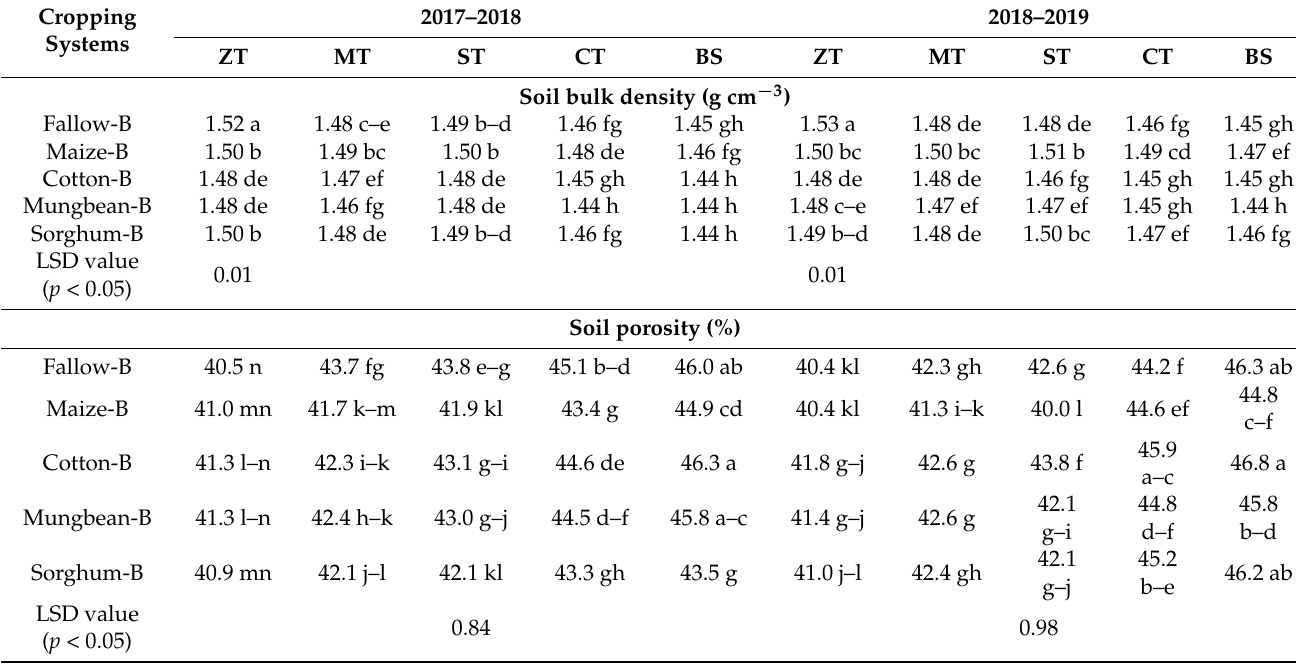
Table 3. Impact of barley-based cropping systems on soil bulk density and soil porosity after barley harvest under conventional and conservation tillage